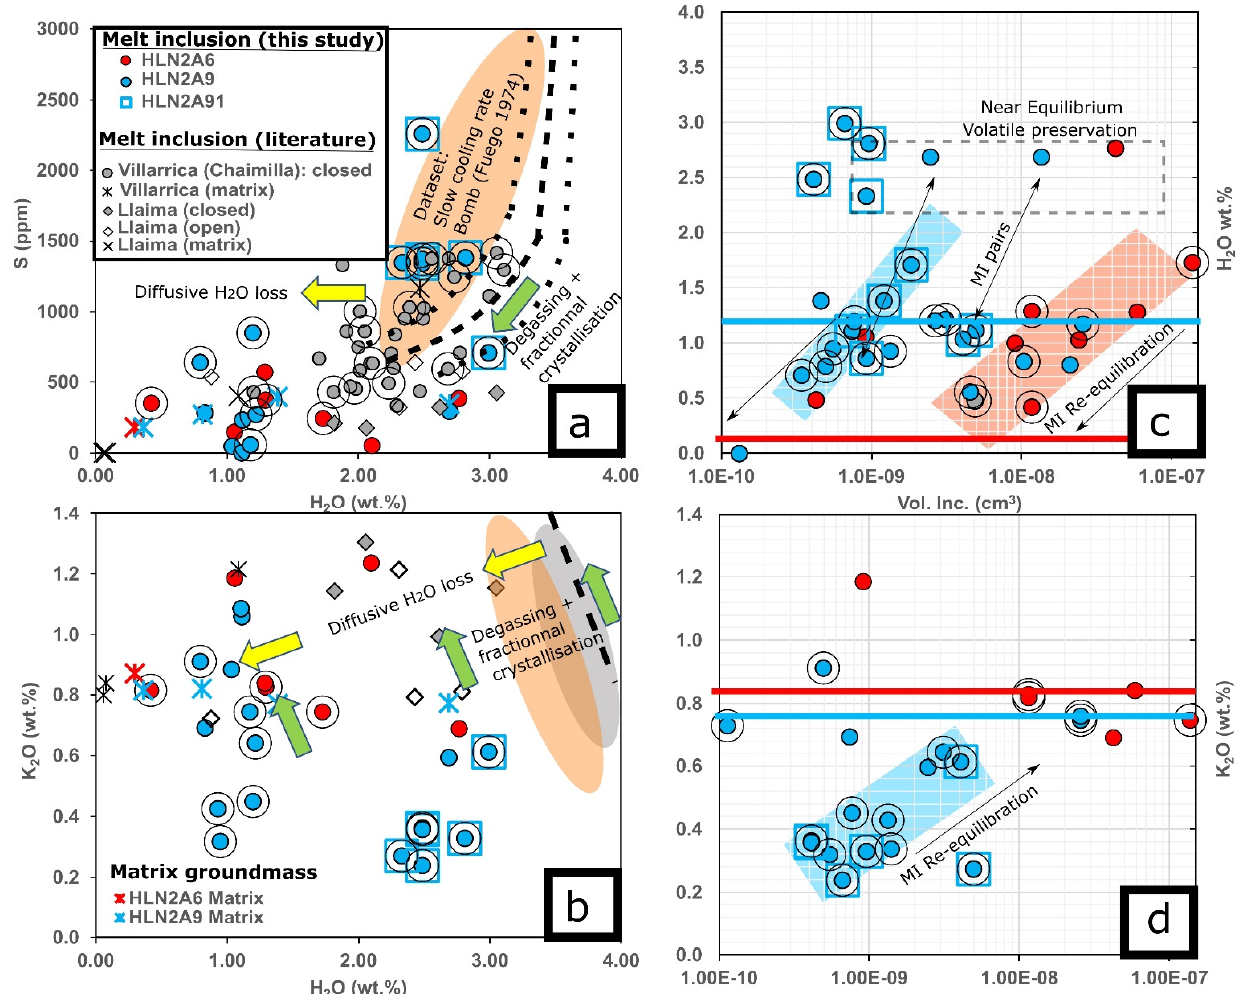
Figure 5. Factors controlling preservation of volatiles in LNG2 samples. The sample HLN2a91 has n = 10 data represented by a blue rim square. ( a ) H 2 O versus sulfur variation in MIs from this LNG2 highlighting the effect of diffusive water loss with yellow arrow. The solid dashed line represents the approximate limits for batch fractionation model used by Lloyd [63]. The degassing model tilted line represents an inclusion dataset of uncorrected ash and lapilli MIs from Lloyd et al. (2013) and its extension (dotted lines), while the reddish ellipse represents the inclusions from the bomb sample affected by water diffusion. All symbols with large transparent circles represent inclusions with an observed vapor bubble. Literature MIs data from Llaima volcano and Chaimilla event at Villarrica are mentioned in Supplementary Material Figure S6. ( b ) K 2 O versus H 2 O variation in MIs from LNG2 to distinguish between diffusive H 2 O loss (yellow arrow) and degassing + fractional crystallization (green arrow). Grey ellipse dataset of uncorrected ash and lapilli MIs from Lloyd et al. (2013). ( c ) H 2 O versus inclusion volume (Vol. Inc. in cm 3 ) variation in MIs. Matrix glass maximums H 2 O wt.% contents are represented by red (HLN2A6) and blue (HLN2A9) horizontal lines. Two end member arrows are linking two closed MIs pairs with clear distinction between CO 2 contents between the presence of an observed bubble (or not). ( d ) K 2 O wt.% versus inclusion volume in cubic centimeters (Vol. Inc. in cm 3 ).